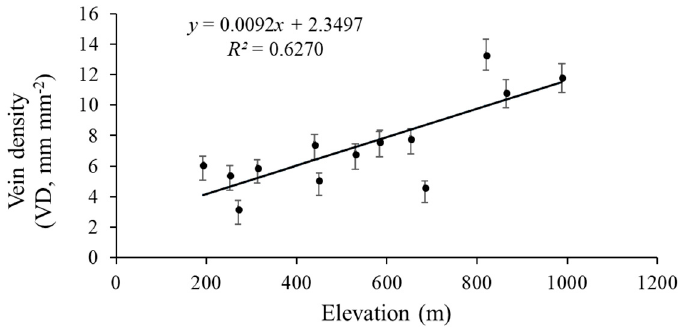
Figure 6. Regression analysis of the VD (mean ± SD) with elevation. The VD is significantly related to the elevation ( p = 0.0007). Each dot represents a sampling site in China.